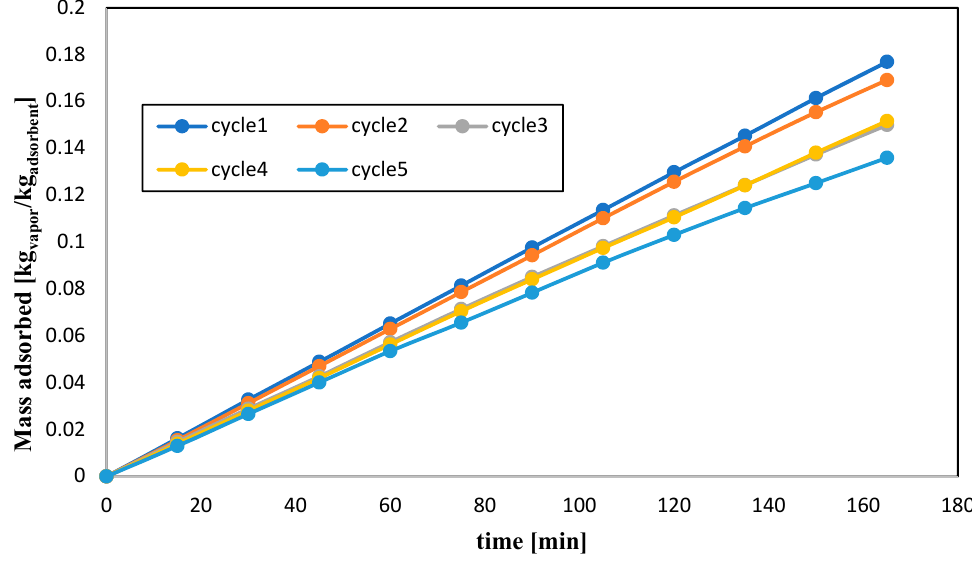
Figure 4. Cumulative mass adsorbed.